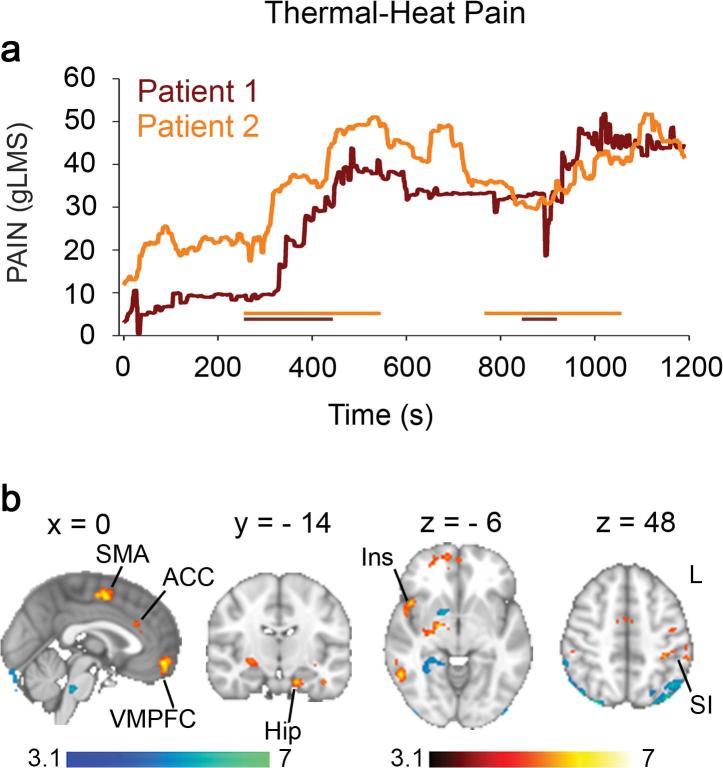
Thermal heat pain. (a) Example of two thermal pain ratings obtained while the warming boot was turned on and off. The colored horizontal lines indicate the timings of the thermal stimuli. (b) Brain activity associated with thermal pain in subjects with IEM due to the S241T Nav1.7 mutation. Brain activity associated with rating of thermal pain in subjects with IEM. Areas shown in red to yellow exhibit significant increase (Z > 3.1, p < 0.05, corrected) in activity during thermal pain rating; areas shown in blue to light blue exhibit significant increase in activity during visual rating Abbreviations: R, right; L, Left; ACC, anterior cingulate cortex; Hip, hippocampus; Ins, Insula; SMA, supplementary motor area (SMA); SI, primary somatosensory cortex. Color bars, heat maps for unpaired t-test statistics. (For interpretation of the references to color in this figure legend, the reader is referred to the web version of this article.)